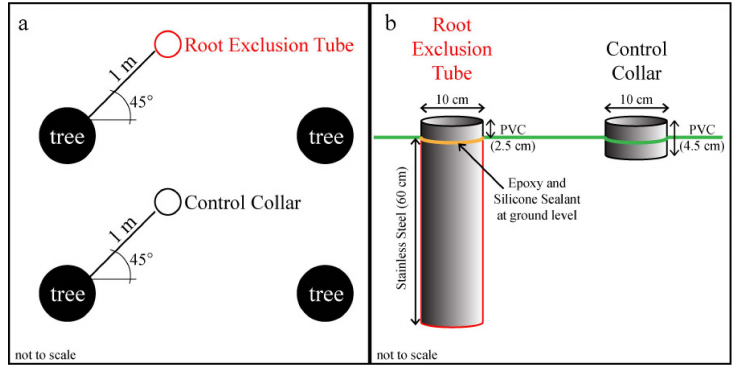
Figure 1. Experimental design schematics showing: ( a ) the random placement of root exclusion tubes and control collars 1 m from trees at a 45 ˝ angle from the tree rows; and ( b ) the size and composition of the root exclusion tubes and control collars. This study was conducted in three longleaf pine ( Pinus palustris Mill.)